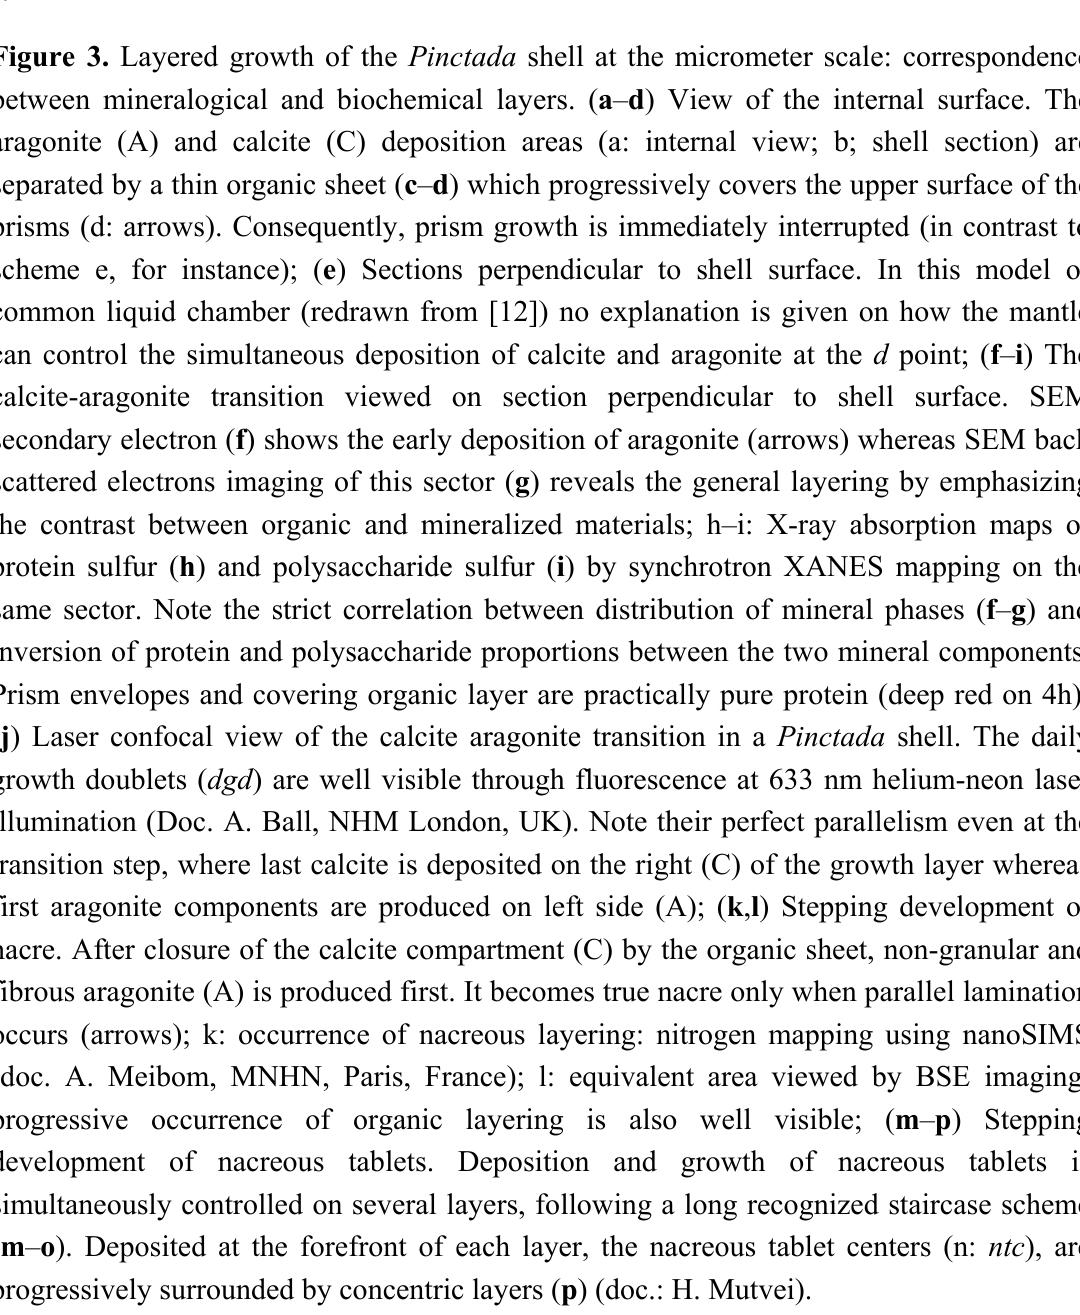
Figure 3. Layered growth of the Pinctada shell at the micrometer scale: correspondence between mineralogical and biochemical layers. ( a – d ) View of the internal surface. The aragonite (A) and calcite (C) deposition areas (a: internal view; b; shell section) are separated by a thin organic sheet ( c – d ) which progressively covers the upper surface of the prisms (d: arrows). Consequently, prism growth is immediately interrupted (in contrast to scheme e, for instance); ( e ) Sections perpendicular to shell surface. In this model of common liquid chamber (redrawn from [12]) no explanation is given on how the mantle can control the simultaneous deposition of calcite and aragonite at the d point; ( f – i ) The calcite-aragonite transition viewed on section perpendicular to shell surface. SEM secondary electron ( f ) shows the early deposition of aragonite (arrows) whereas SEM back scattered electrons imaging of this sector ( g ) reveals the general layering by emphasizing the contrast between organic and mineralized materials; h–i: X-ray absorption maps of protein sulfur ( h ) and polysaccharide sulfur ( i ) by synchrotron XANES mapping on the same sector. Note the strict correlation between distribution of mineral phases ( f – g ) and inversion of protein and polysaccharide proportions between the two mineral components. Prism envelopes and covering organic layer are practically pure protein (deep red on 4h); ( j ) Laser confocal view of the calcite aragonite transition in a Pinctada shell. The daily growth doublets ( dgd ) are well visible through fluorescence at 633 nm helium-neon laser illumination (Doc. A. Ball, NHM London, UK). Note their perfect parallelism even at the transition step, where last calcite is deposited on the right (C) of the growth layer whereas first aragonite components are produced on left side (A); ( k , l ) Stepping development of nacre. After closure of the calcite compartment (C) by the organic sheet, non-granular and fibrous aragonite (A) is produced first. It becomes true nacre only when parallel lamination occurs (arrows); k: occurrence of nacreous layering: nitrogen mapping using nanoSIMS (doc. A. Meibom, MNHN, Paris, France); l: equivalent area viewed by BSE imaging: progressive occurrence of organic layering is also well visible; ( m – p ) Stepping development of nacreous tablets. Deposition and growth of nacreous tablets is simultaneously controlled on several layers, following a long recognized staircase scheme ( m – o ). Deposited at the forefront of each layer, the nacreous tablet centers (n: ntc ), are progressively surrounded by concentric layers ( p ) (doc.: H.